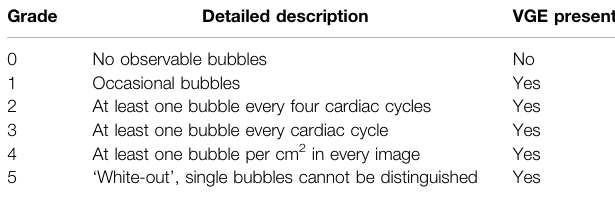
TABLE 2 | Interpretation of the kappa statistic proposed by Landis et al., 1977 (Landis and Koch, 1977). Below